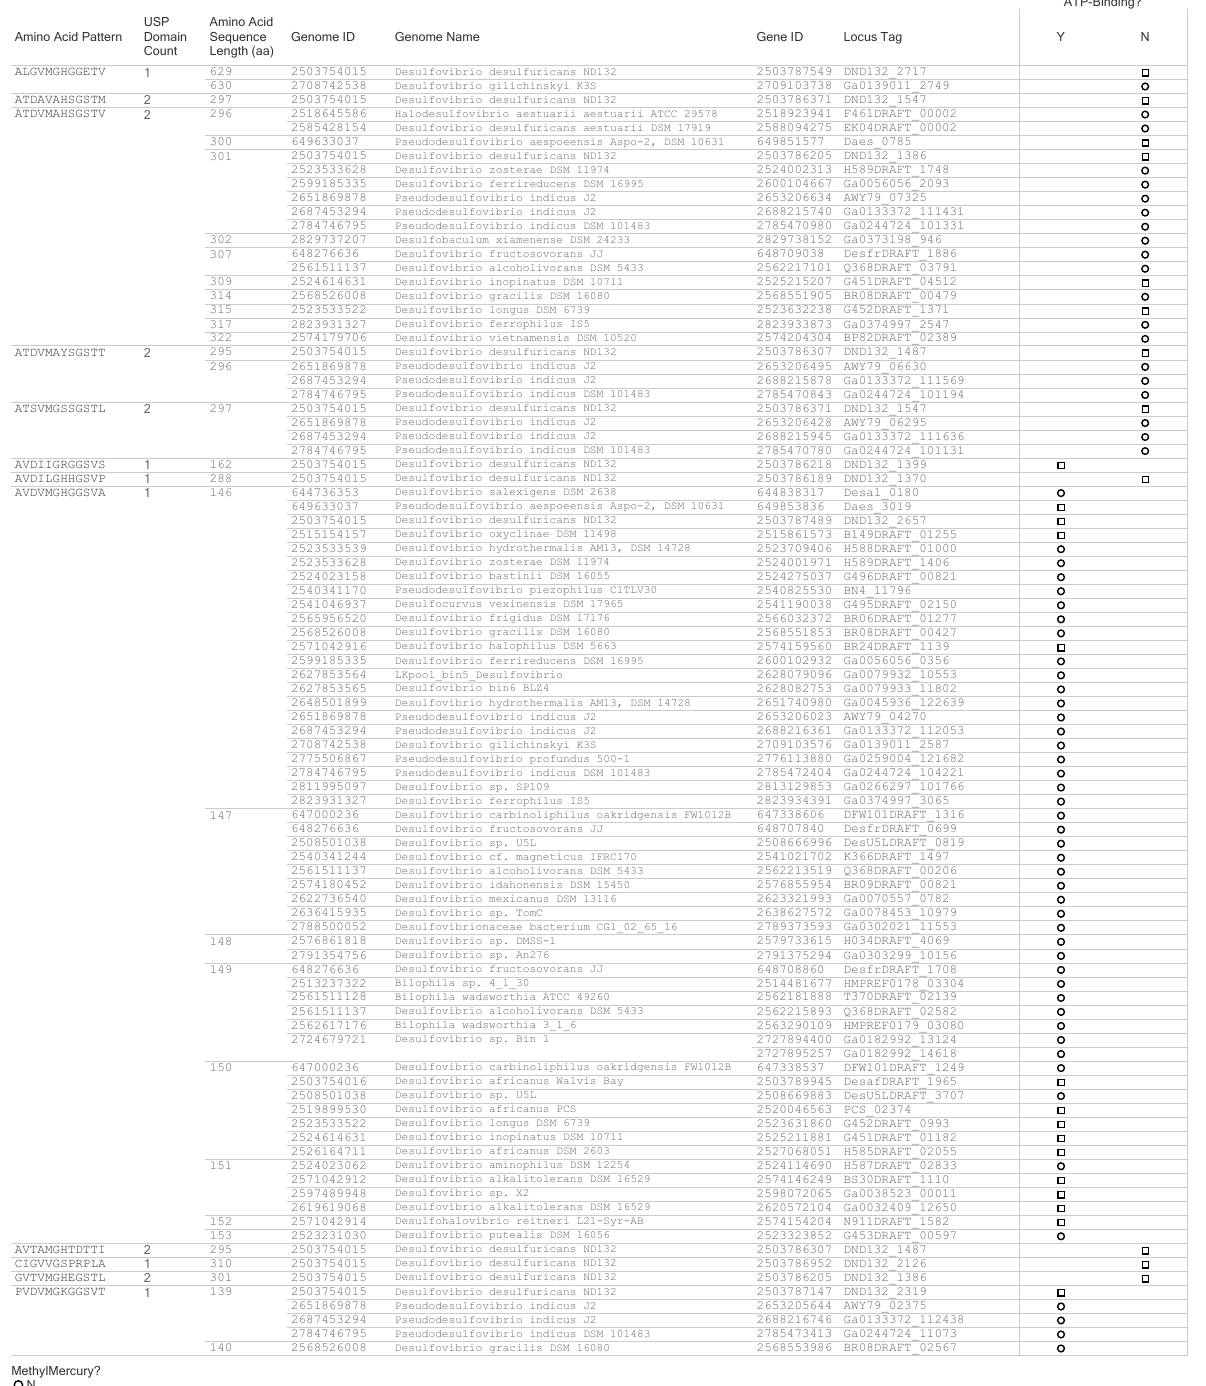
Figure A2. Profiling of 92 Desulfovibrionaceae universal stress proteins by amino acid pattern (functional sites for ATP binding), protein domain count, amino acid length, ATP-binding motif, and mercury methylation status of source bacteria. The interactive version of the visual is available at https://public.tableau.com/app/profile/qeubic/viz/uspdesulfofamily/ figureB1 (accessed on 20 August